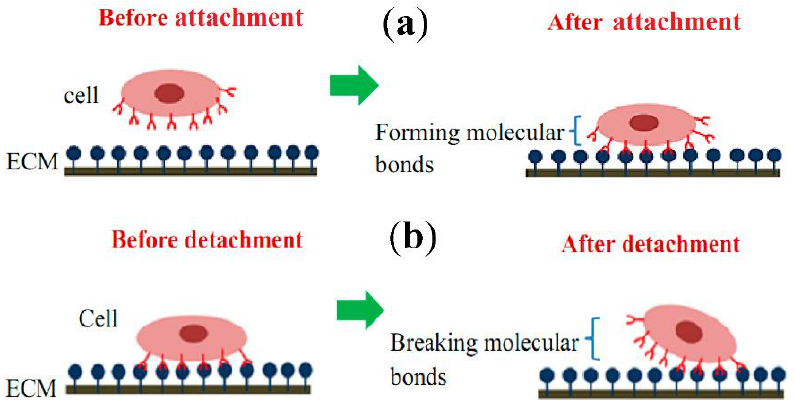
Figure 2. Schematic diagram of single-cell adhesion ( a ) attachment event via the formation of molecular bonds, ( b ) detachment event via breakage of molecular bonds. (ECM—Extracellular matrix) (Reproduced with permission from [25] under Creative Commons Attribution 4.0 International License).